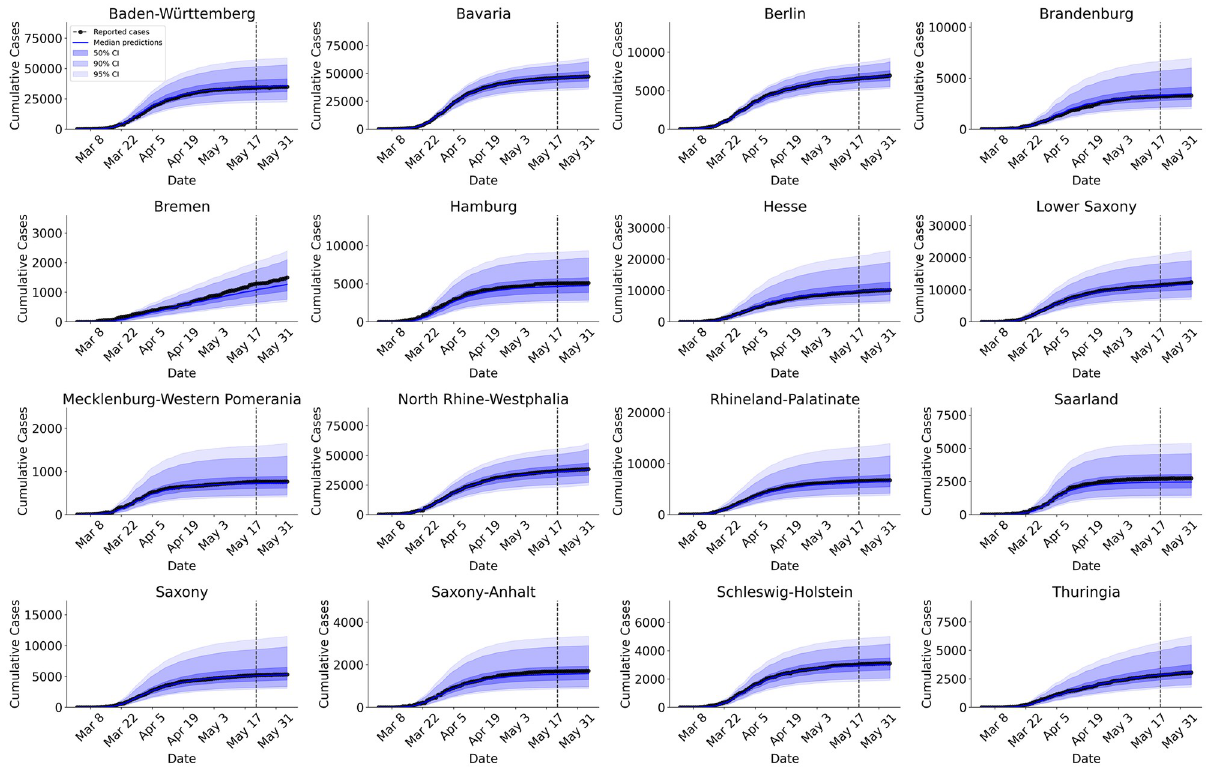
Fig 5. Model predictions of cumulative Covid-19 cases (derived from estimated new cases) for each German federal state. Cases to the left of the vertical dashed line (8 weeks) were used for model fitting and posterior checking and cases to the right (3 weeks) for forecasts on new data. We observe that median model predictions closely match both past and future reported cases for each German federal state. Most importantly, the reported cases always lie within the estimated CIs, which vary across the federal states.